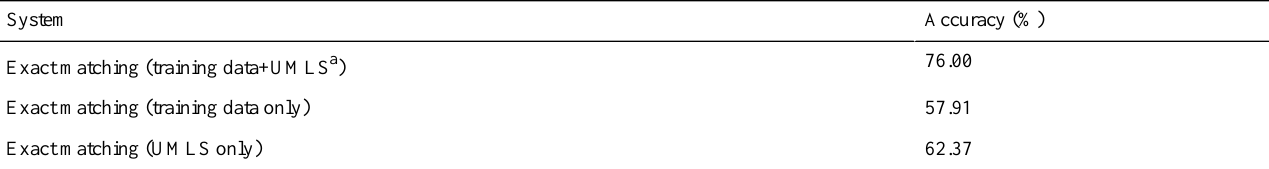
Table 2. Performance evaluation on the clinical term normalization task using only exact matching.